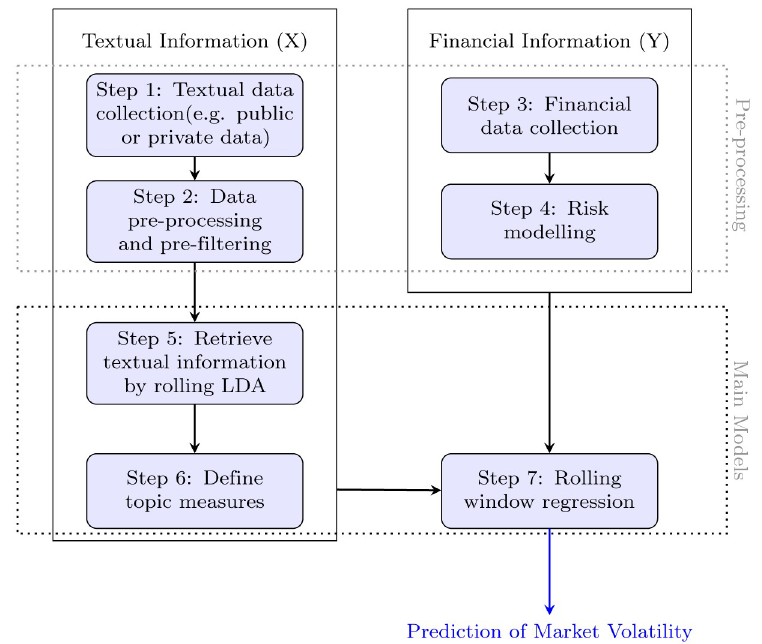
Fig 1. Methodology flow chart. An overview of the entire research methodology from data collection to market volatility prediction. The methodology consists of seven steps, with the aim of making a prediction on market